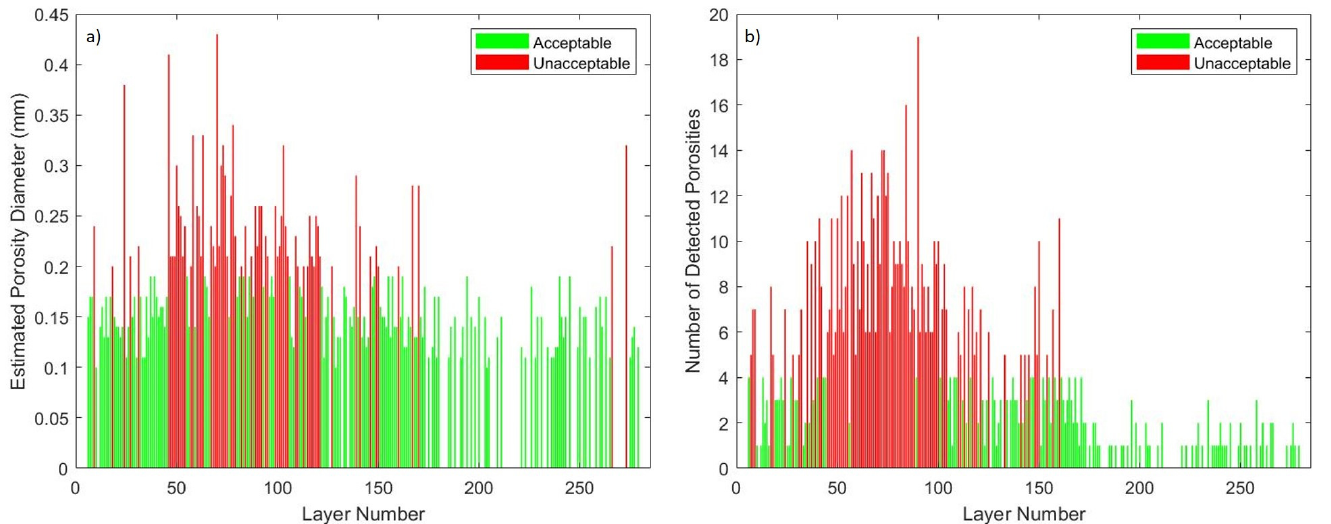
Figure 14. Porosity inter-layer evaluation: ( a ) low-density diameter of Sample 1 (mm) and ( b ) low- density quantity of sample